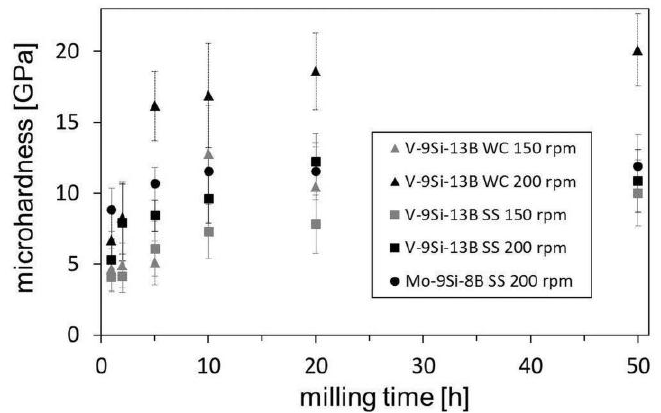
Figure 6. Microhardness evolution of V-9Si-13B and Mo-9Si-8B during the mechanical alloying process using different milling parameters (SS—stainless steel; WC—tungsten carbide).